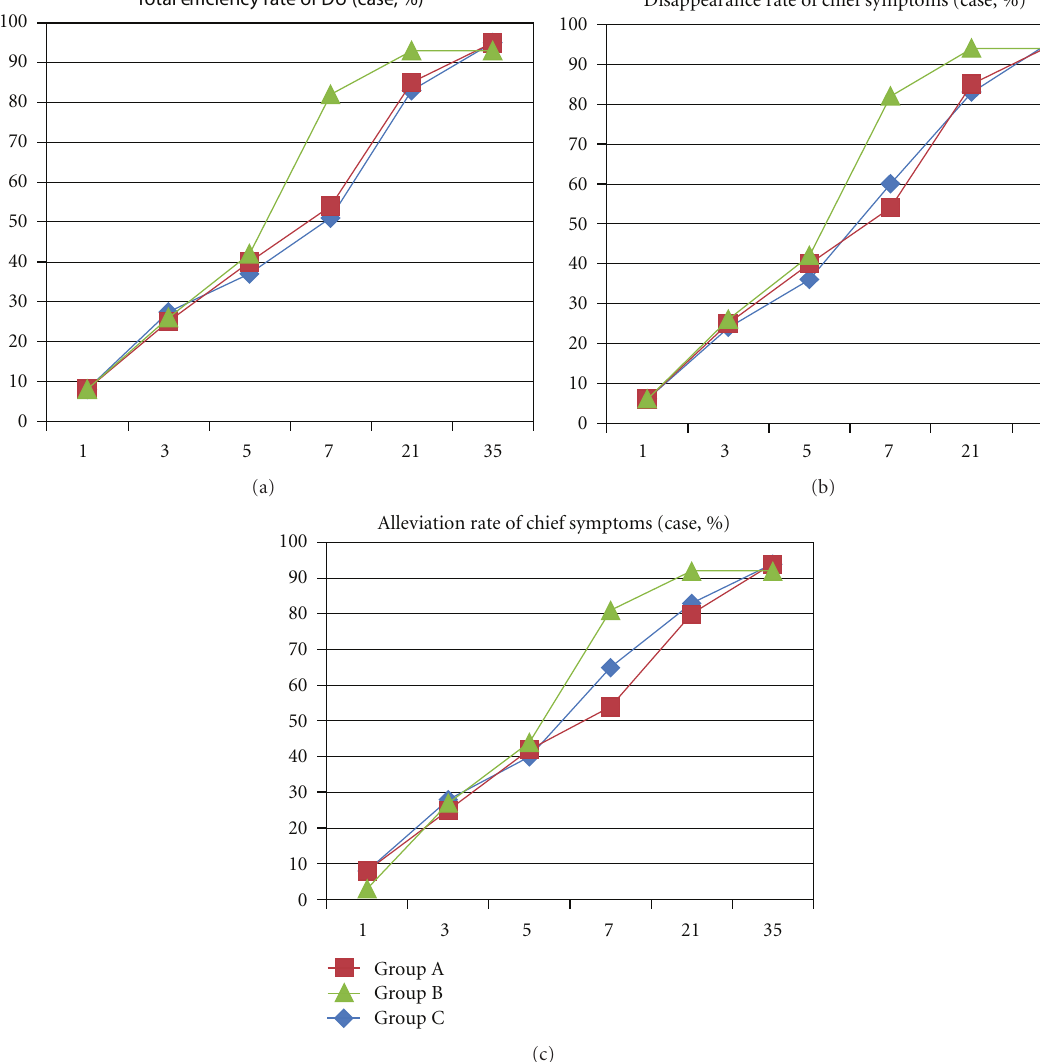
Figure 2: The trend of duodenal-ulcer-associated symptoms in the four groups. Time courses of the mean value of symptom scores are shown in the graphs. The x -axis represents days from baseline and the y -axis represents the change rate of symptom score in DU patients. (The lines represent the trend rather than a continuous